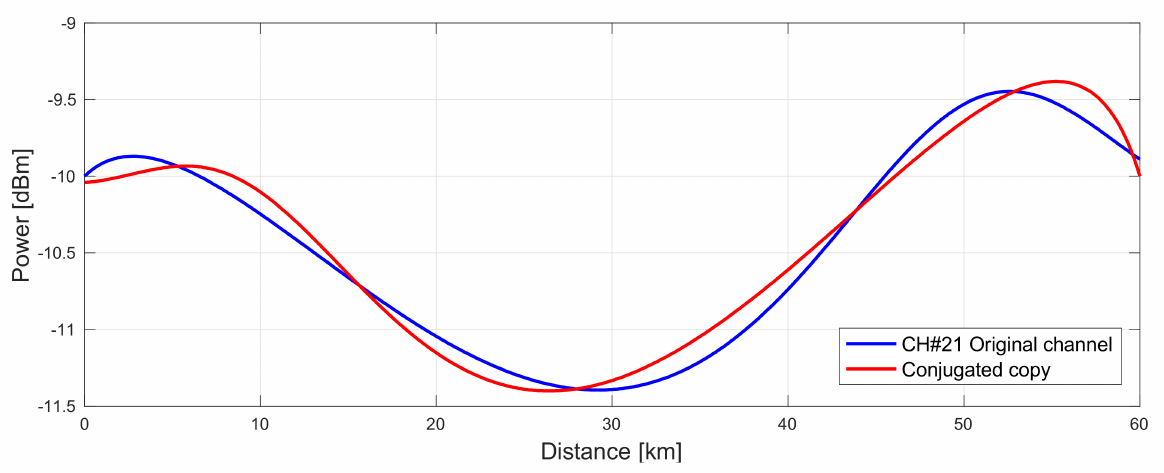
Figure 12. Signal power profile of original (blue) and conjugated (red) channel with lowest asymmetry of 2.1% in a 60 km standard SMF span.